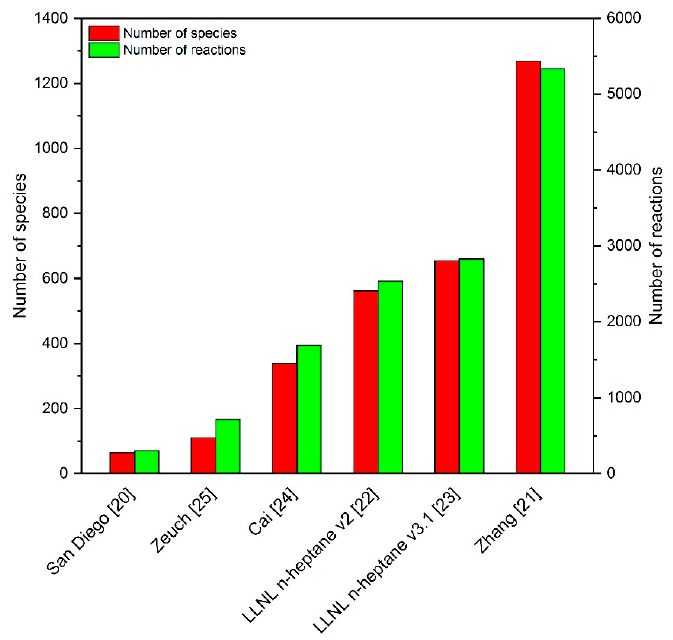
Figure 1. Number of species and reactions of the investigated reaction mechanisms.